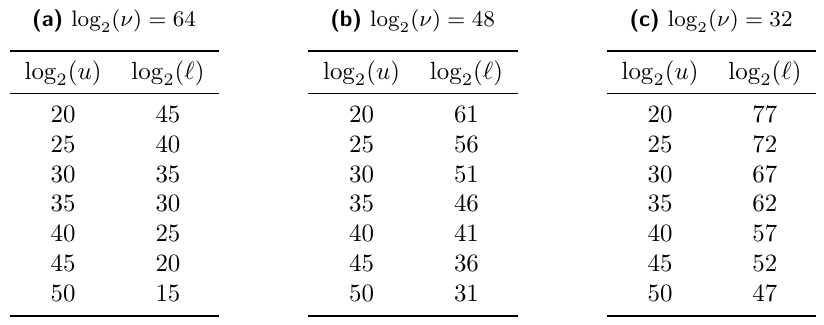
Table 6: These tables are showing the relation between the number of user and number of offline block cipher calls required to get a key-recovery advantage near 1 key size of κ = 128 bits, a block size of n = 128 bits and section size s =